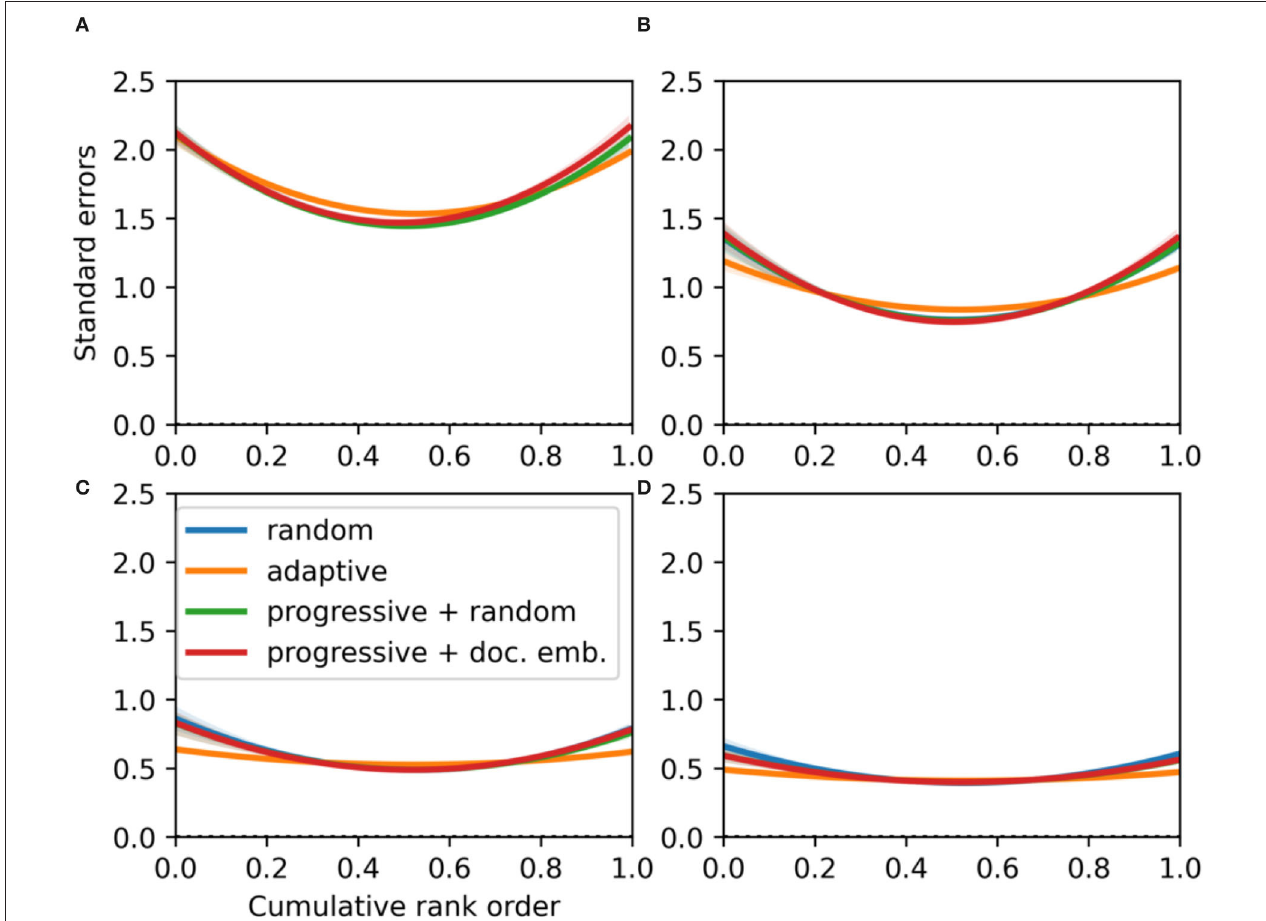
FIGURE 8 | For essay set 2 ( N 2 = 150), standard error of quality parameter estimates with respect to their cumulative ranking for different averages of work comparisons: 5 (A) , 10 (B) , 20 (C) , and 30 (D) , respectively. This is assessed for different selection rules: random (CJ), adaptive (ACJ), and a progressive selection with a random component and with a similarity component using document embeddings (100 simulations). The solid lines indicate the mean values and the transparent bands indicate the 95% point-wise